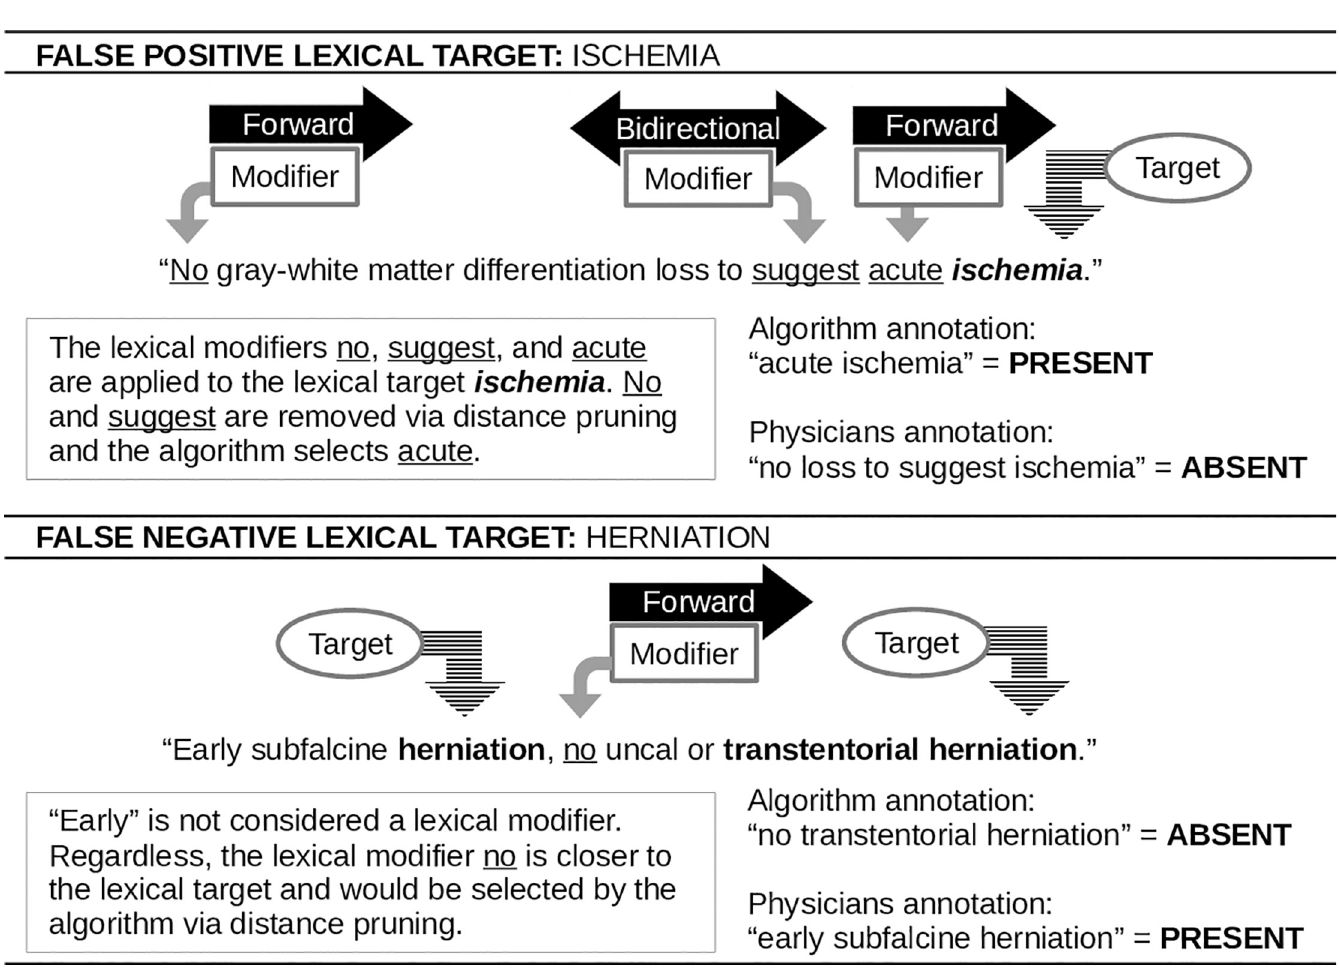
Fig 6. Divergent annotation examples. Two examples of divergent annotations between annotators and tbiExtractor.